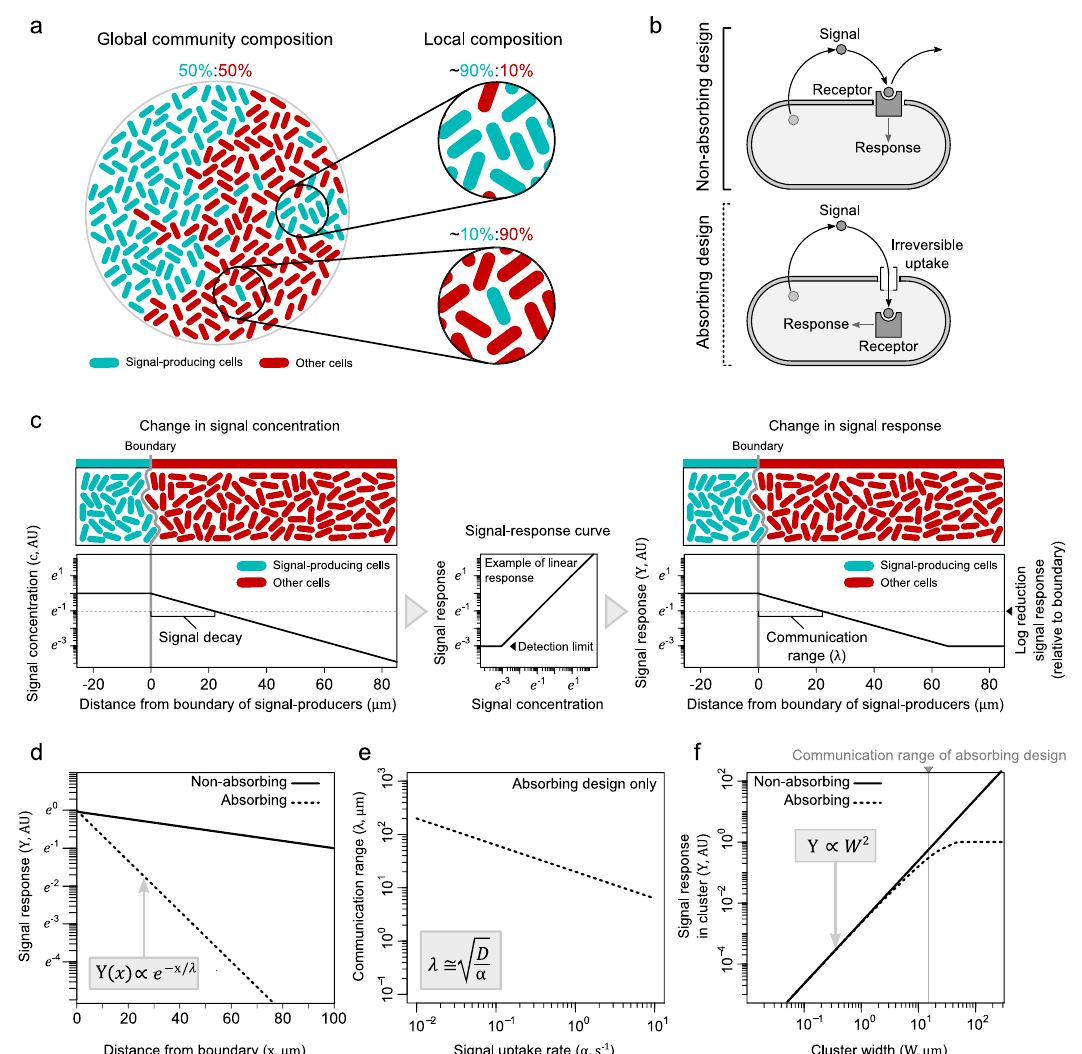
Fig. 1 Predicted communication ranges in absorbing and nonabsorbing quorum-sensing systems. a Differences in community composition at local and global spatial scales. b Quorum-sensing designs (see also Supplementary Fig. 4). c Model setup with clusters of signal-producing cells (blue) embedded in a community of nonproducers (red). In the case of linearity in both signal response and uptake, the spatial decay in the signal concentration (left) corresponds to that in signal response (right). We de fi ne the communication range ( λ ) as the distance from the boundary of signal producers over which the signal response reduces one order of magnitude (on a natural log scale; dashed horizontal line) (see Supplementary Discussion, Section 1.3 and Supplementary Fig. 1). d Decline in signal response ( Y ) in absorbing (dashed line) and nonabsorbing (solid line) systems as a function of the distance ( x , in μ m) from the boundary of signal producers. e Communication range as a function of signal uptake rate ( α ) in absorbing systems (for nonabsorbing systems α ¼ 0). Uptake rates used here are of realistic values for RNPP systems 29,30 and the signal diffusion rate used is 400 μ m 2 s − 1 (Supplementary Discussion, Section 1.4.2). f Average signal response in clusters of signal producers with different widths ( W ). Equations in ( c – e ) show analytical modeling predictions for the absorbing system. For a more detailed mathematical comparison of different quorum-sensing designs see Supplementary Discussion, Section